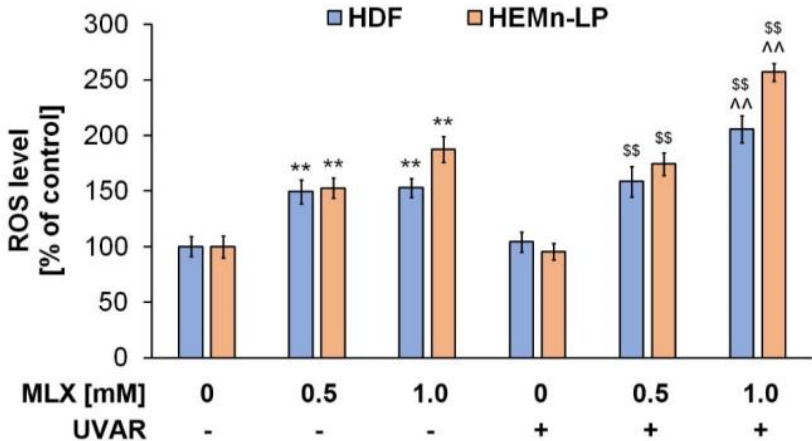
Figure 7. Redox homeostasis in HDF and HEMn-LP cell lines exposed to MLX and/or UVAR. The cells were treated with MLX at concentrations of 0.5 mM and 1 mM for 24h and exposed to UVAR. H 2 DCFDA assay was conducted to determine the intracellular ROS level. Obtained results were calculated as the percentage of control. ** p < 0.01 vs untreated cells (control), $$ p < 0.01 vs irradiated cells (not treated with meloxicam), ^^ p < 0.01 vs corresponding sample not treated with UVAR.